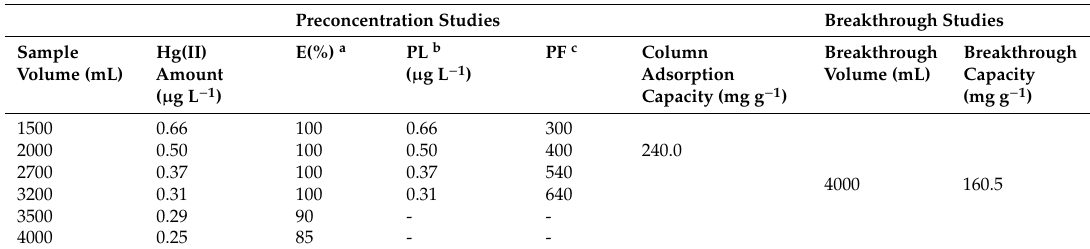
Table 1. Analytical data of preconcentration and breakthrough studies (column parameters: sample